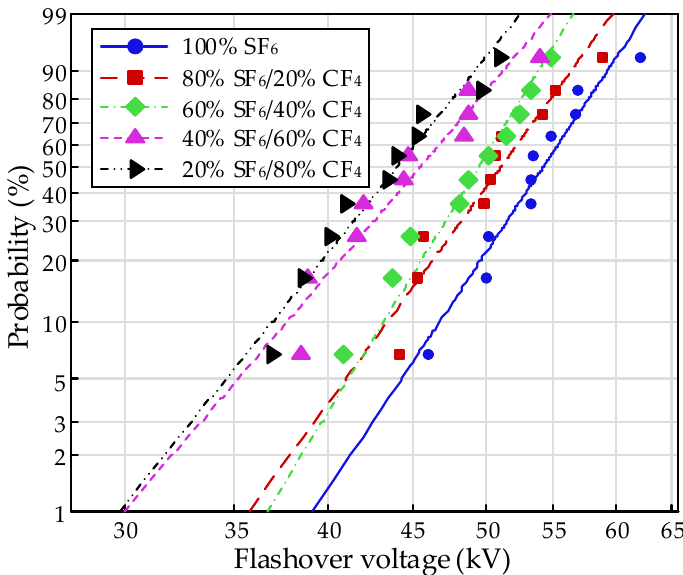
Table 2. Shape and scale parameters with a needle-plate electrode system.